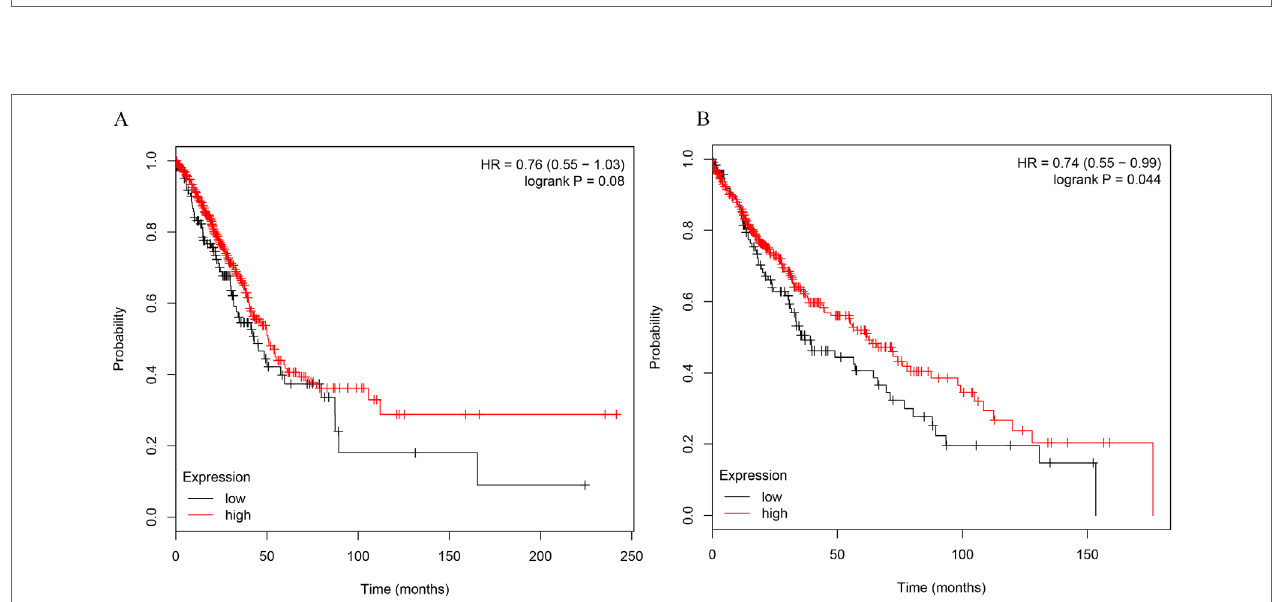
FIGURE 1 | The expression levels of miR-486-5p and correlations with clinical data in NSCLC samples by qRT-PCR. (A) The relative expression levels of miR- 486-5p were calculated by −ΔCt in corresponding tumor tissue and normal tissue. (B) The relative expression levels of miR-486-5p in NSCLC patients’ serum and normal serum by −ΔCt method. (C) The relative expression levels of miR-486-5p were significantly lower in stages II and III compared to stage I ( p < 0.001). (D) The expression levels of miR-486-5p were significantly lower in the larger tumor ( p < 0.001). * p < 0.05, ** p < 0.01, *** p < 0.001.